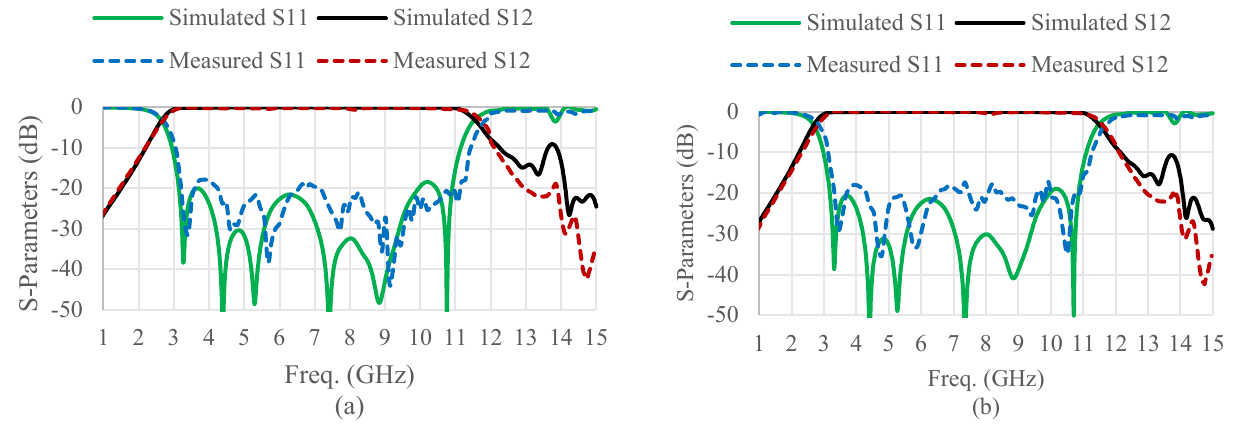
Figure 11. Simulated and measured S-parameters of the proposed filters (represented in Figure 6).